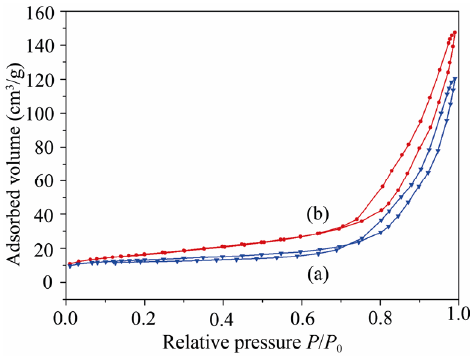
Fig. 4 Nitrogen adsorption–desorption isotherms of the catalysts: (a) MnO x –CeO 2 /TiO 2 and (b) MnO x –CeO 2 / TiO 2 –1%NG.